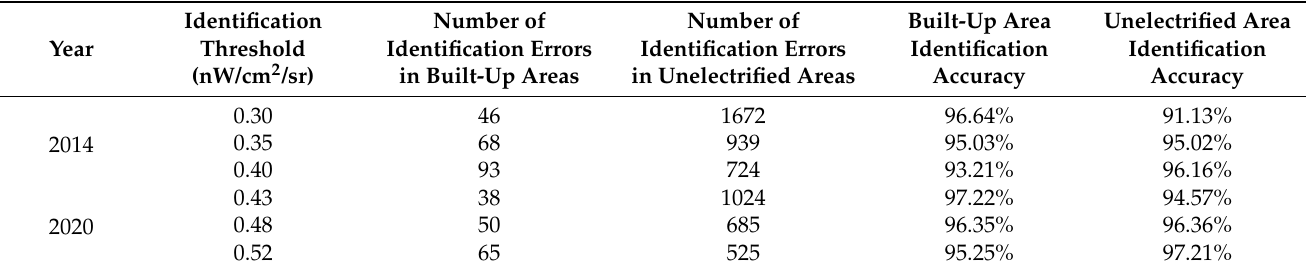
Table 1. Identification accuracy of 20,211 night-light points using different identification